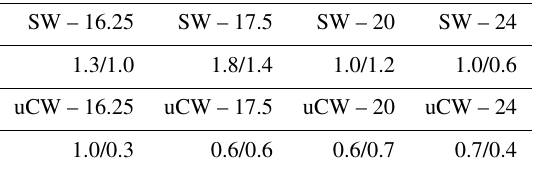
Table 3. Meridional transports observed in November 2008 re- ported in Peña-Izquierdo et al. (2012) (left) and their TROP025 cli- matological equivalent for the month of November (right) separated by the / symbol. Transport values (in Sv) are provided for two dif- ferent density layers (SW for surface waters, σ t < 26 . 46; uCW for upper central waters, 26 . 46 <σ t < 26 . 85) and four latitudes (16.25, 17.5, 20, and 24 ◦ W). In situ values are estimated visually from Fig. 7a–c in Peña-Izquierdo et al. (2012) for the cross-sectional area between the shelf break to 60km offshore. For the model, transport is computed over four grid cells (100km) situated offshore of the shelf break. Using this wider across-shore section is meant to ac- count for our limited horizontal resolution, but transports estimated over only three grid cells only differ by